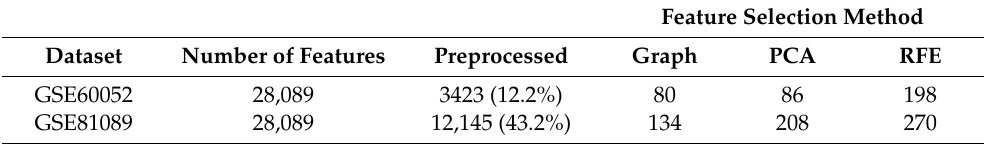
Table 2. Output normalization and feature selection using PCA, RFE and a graph-based approach.